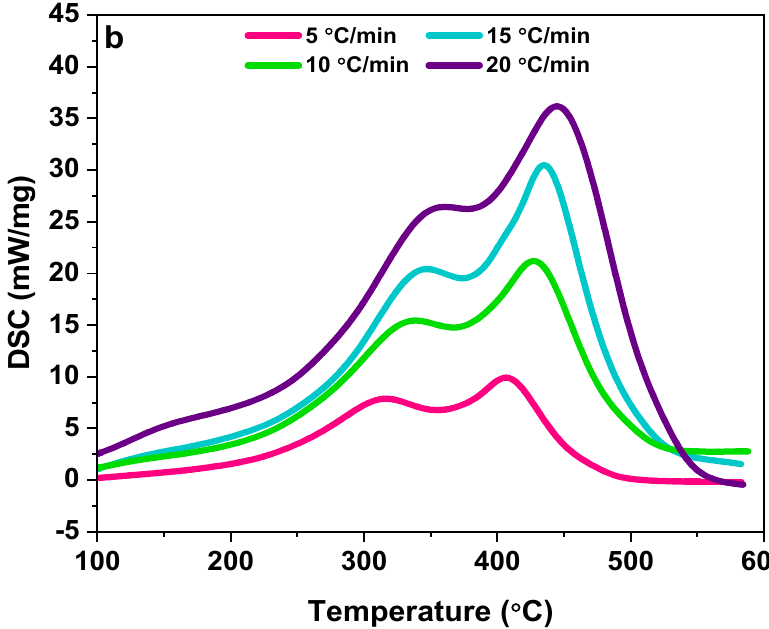
Figure 3 . DSC curves for non-catalytic ( a ) and catalytic ( b ) peat oxidation.